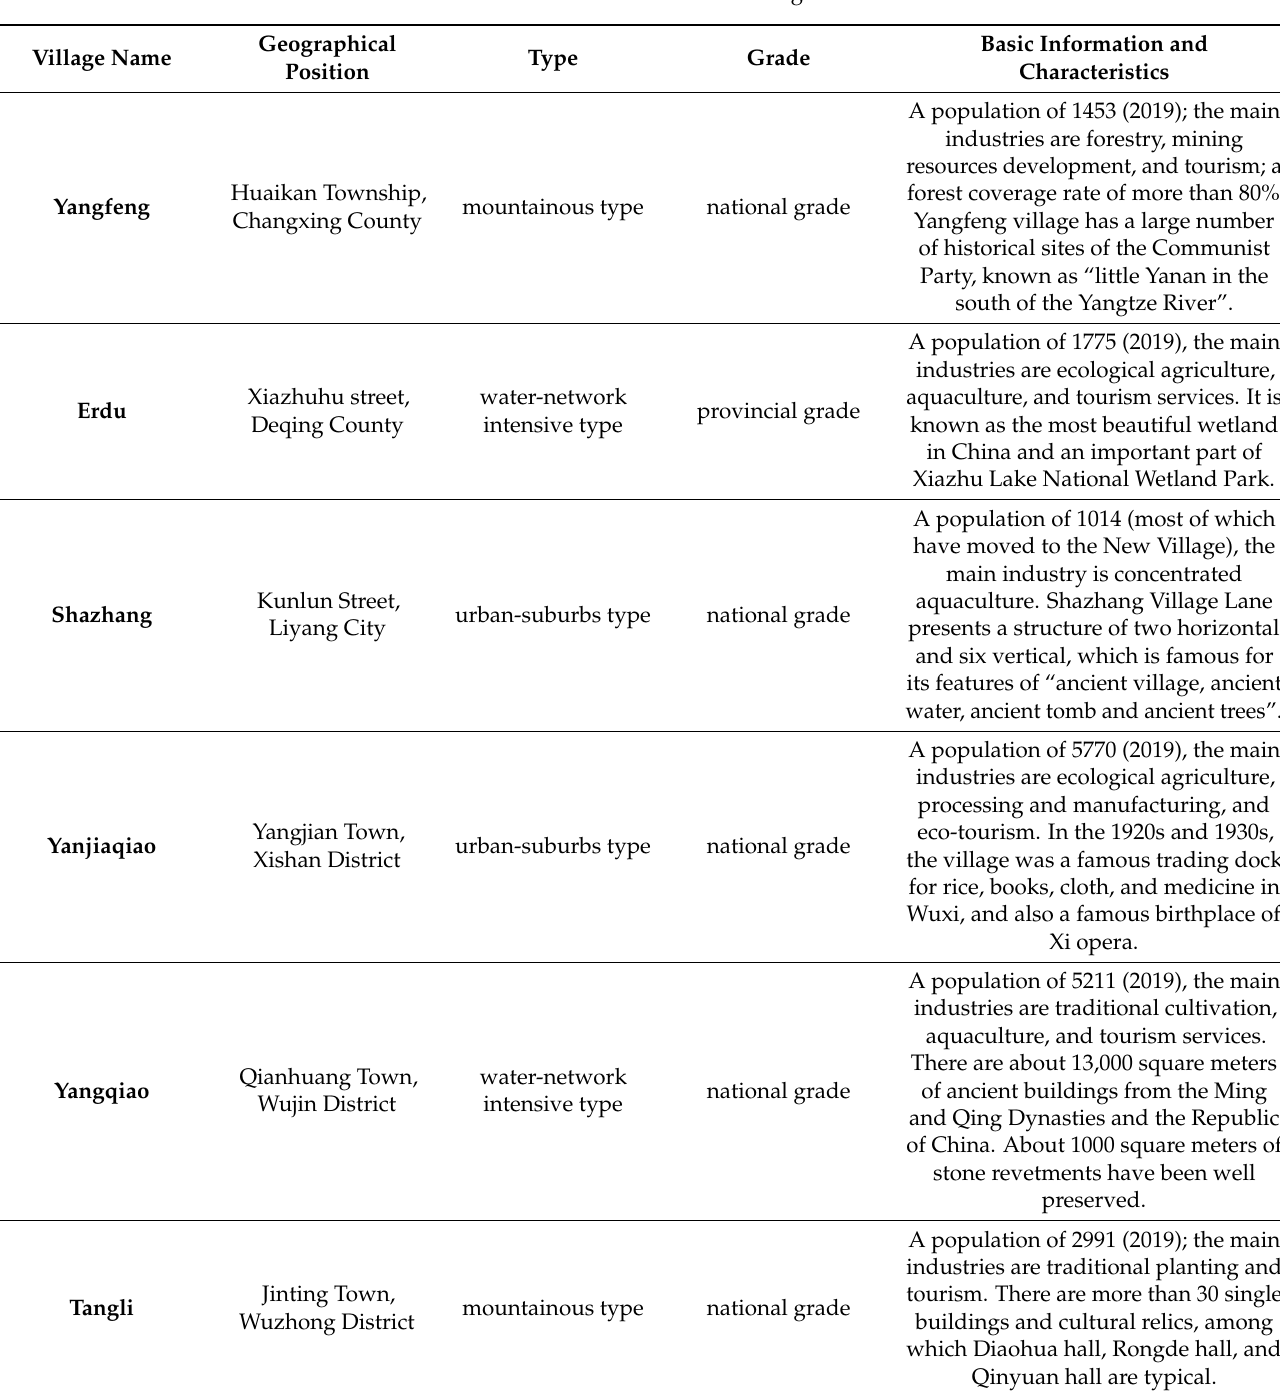
Table 1. Basic information of